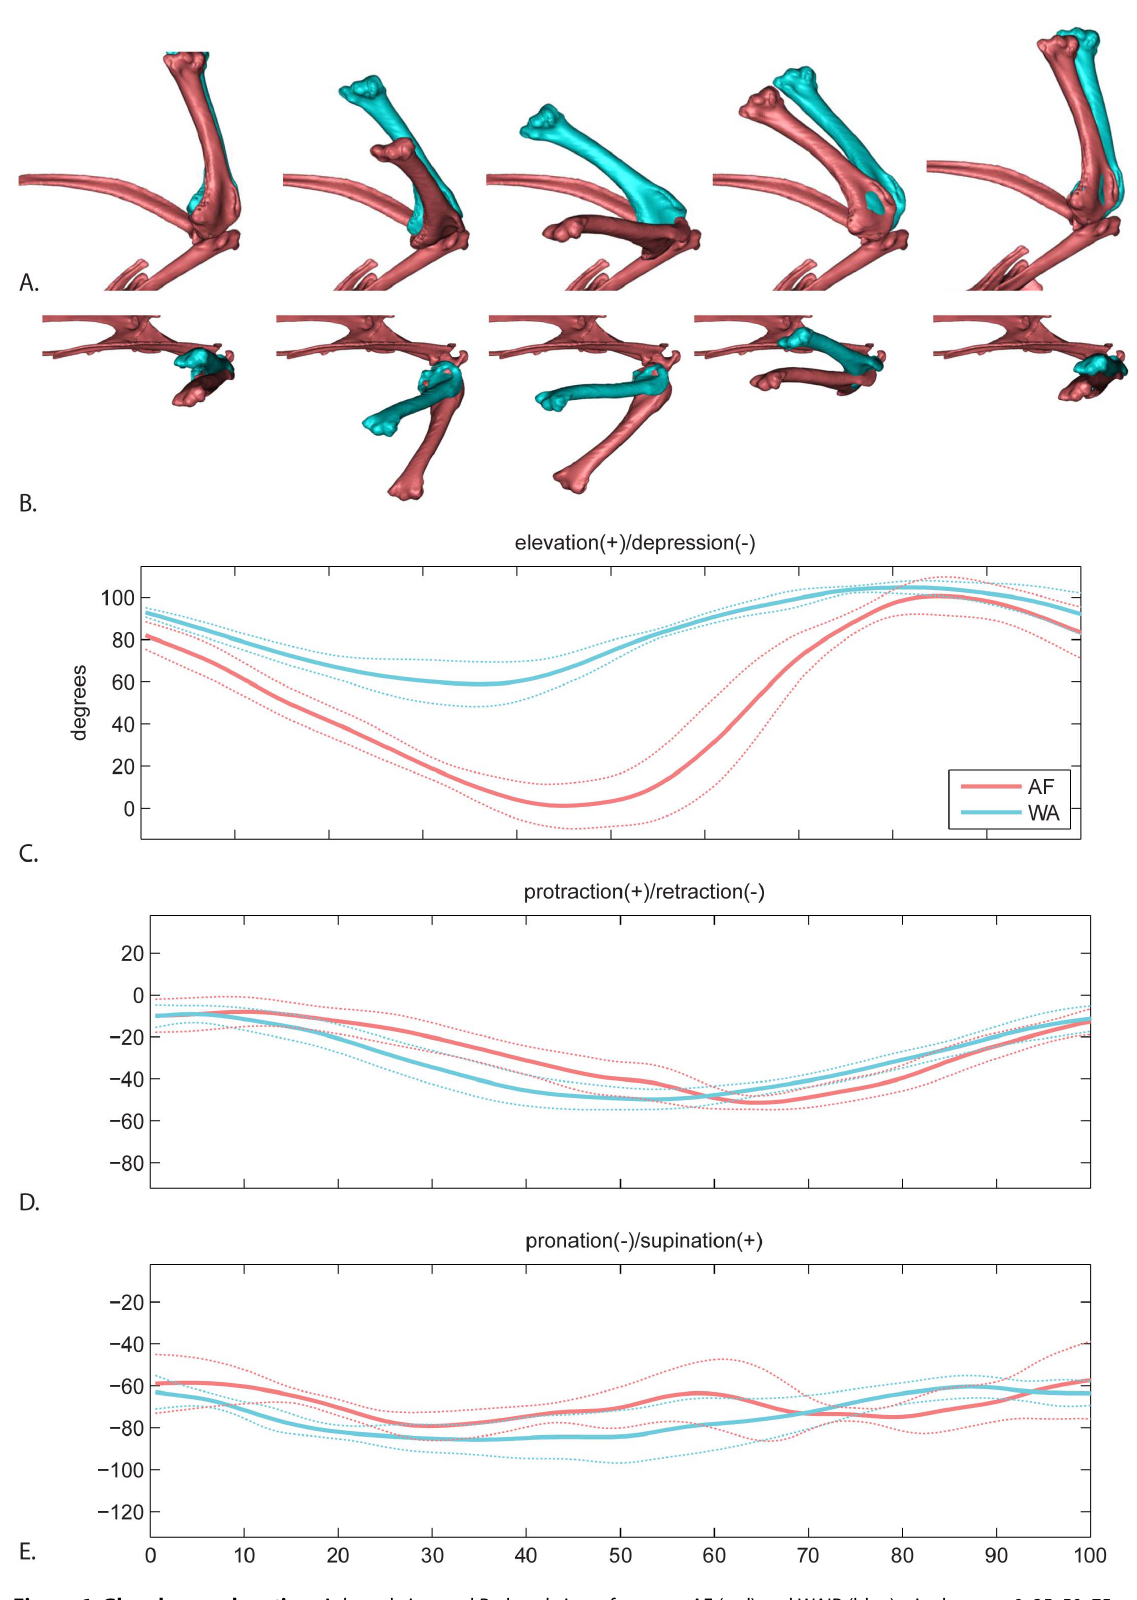
Figure 6. Glenohumeral motion. A. lateral view and B. dorsal view of average AF (red) and WAIR (blue) wingbeats at 0, 25, 50, 75 and 100% of the cycle. Humerus shown relative to a fixed shoulder girdle. C–E mean and standard deviations for each rotational degree of freedom. Time scale 0 to 50%=downstroke, 50–100%=upstroke.